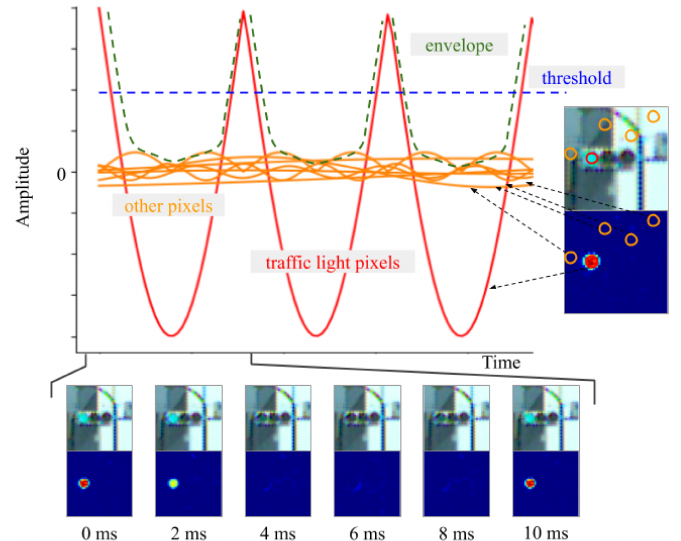
Figure 15. Brightness variation (blinking) for each pixel can be captured by the high-speed camera (images obtained from